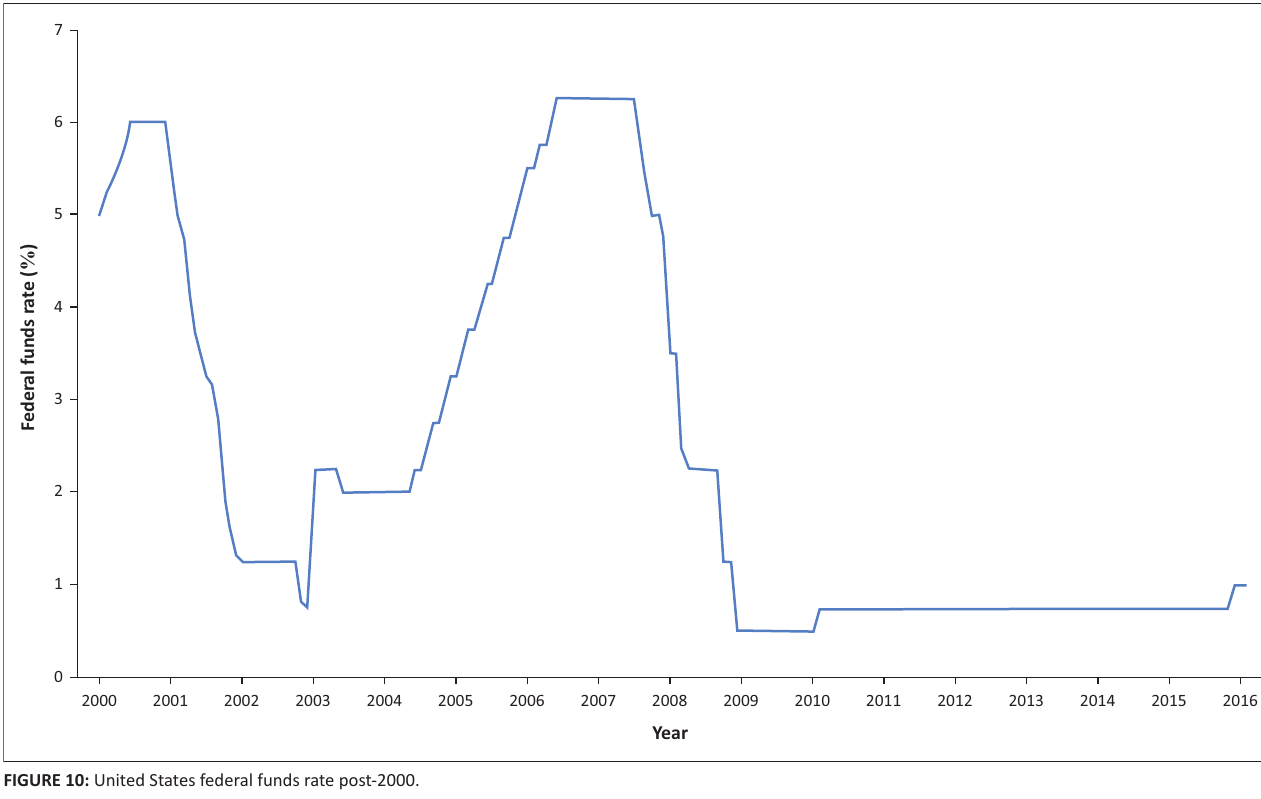
FIGURE 10: United States federal funds rate